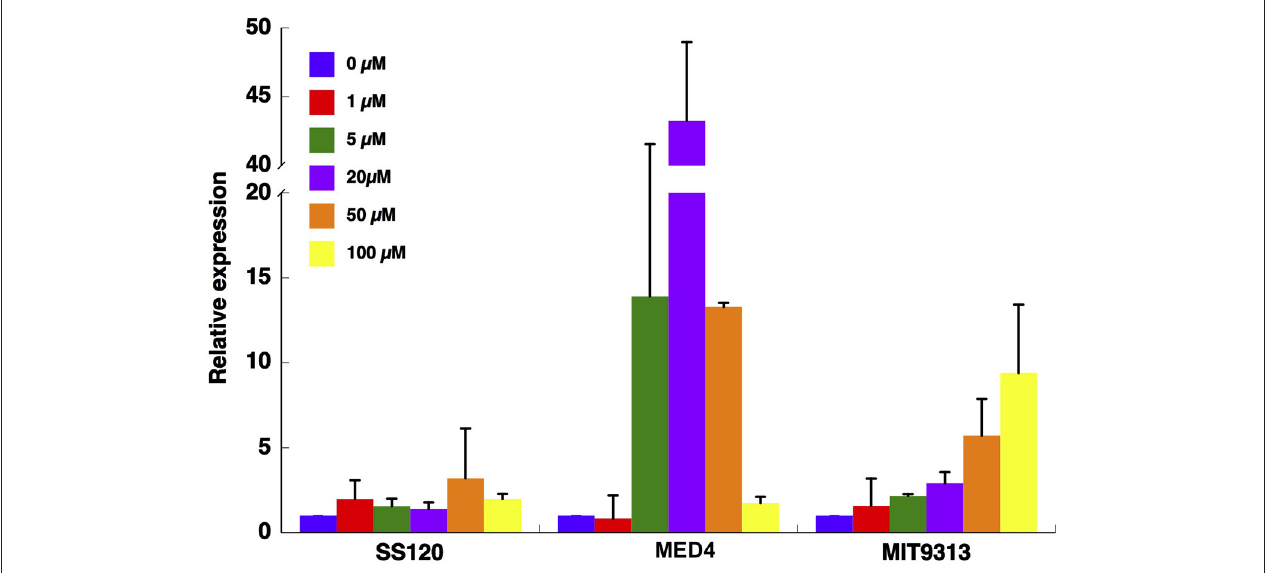
FIGURE 3 | Effect of different concentration of azaserine on ntcA expression in different strains of Prochlorococcus . The different concentrations of azaserine were added to cultures. Samples were collected after 24h, and gene expression was measured by qRT-PCR. Data are the average of four independent biological replicates. Error bars correspond to standard deviation.